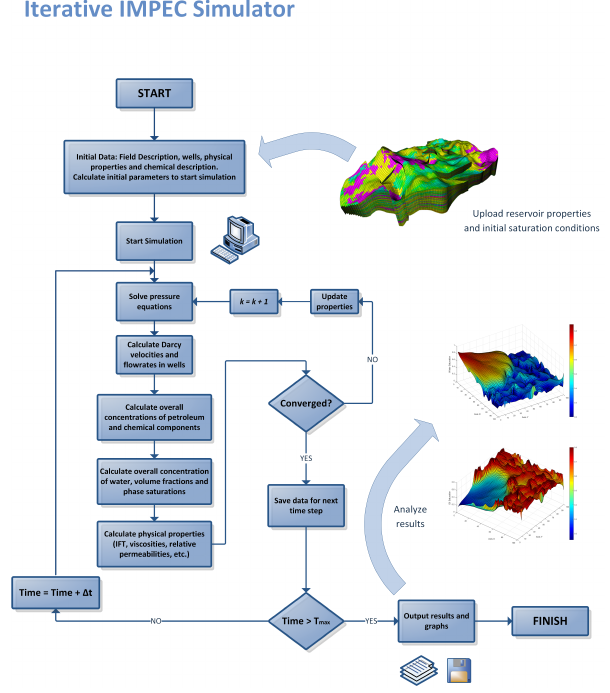
Figure 3. Flowchart representing the steps of the iterative IMPEC